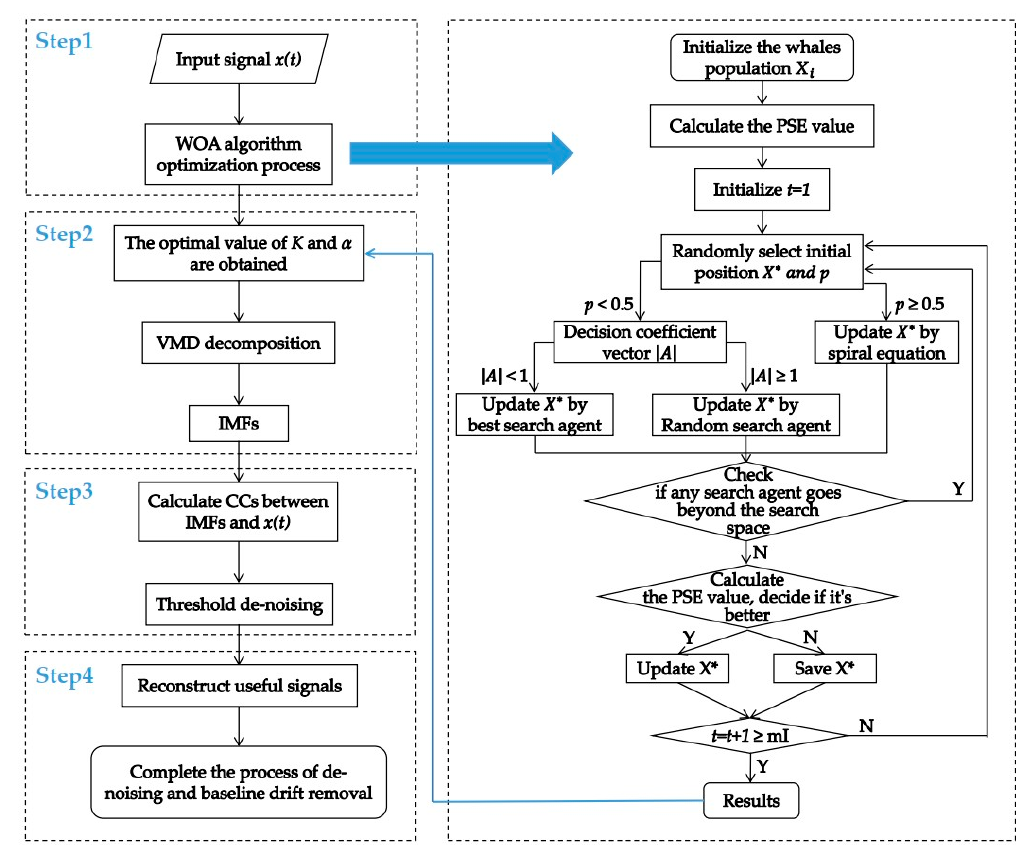
Figure 2. The algorithm proposed in this paper.